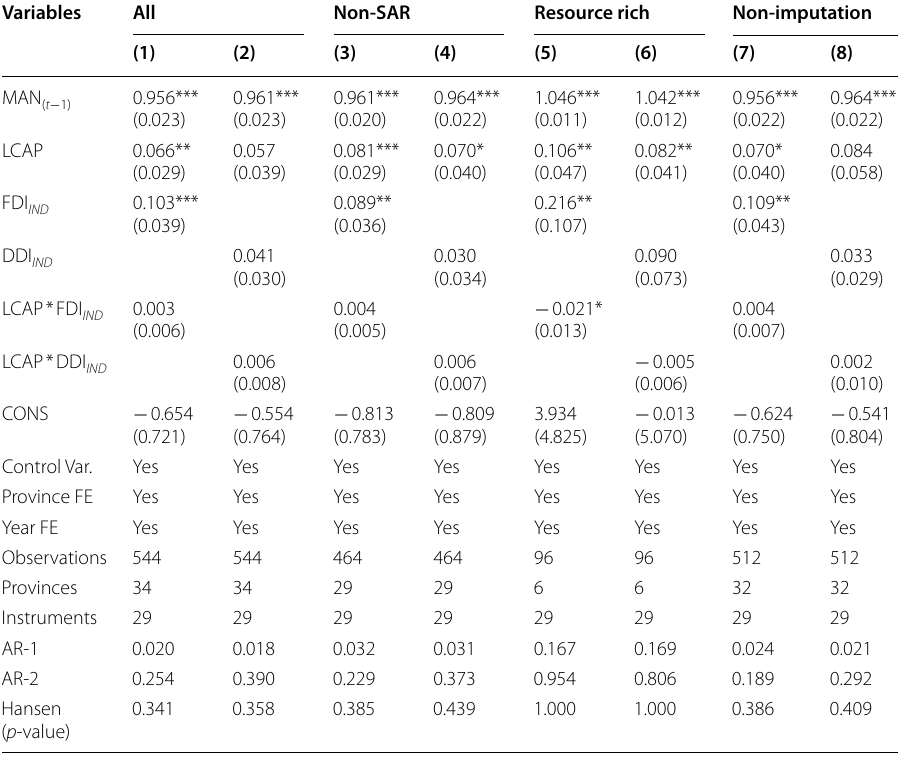
Table 3 Local capital spending and industrial development: interaction